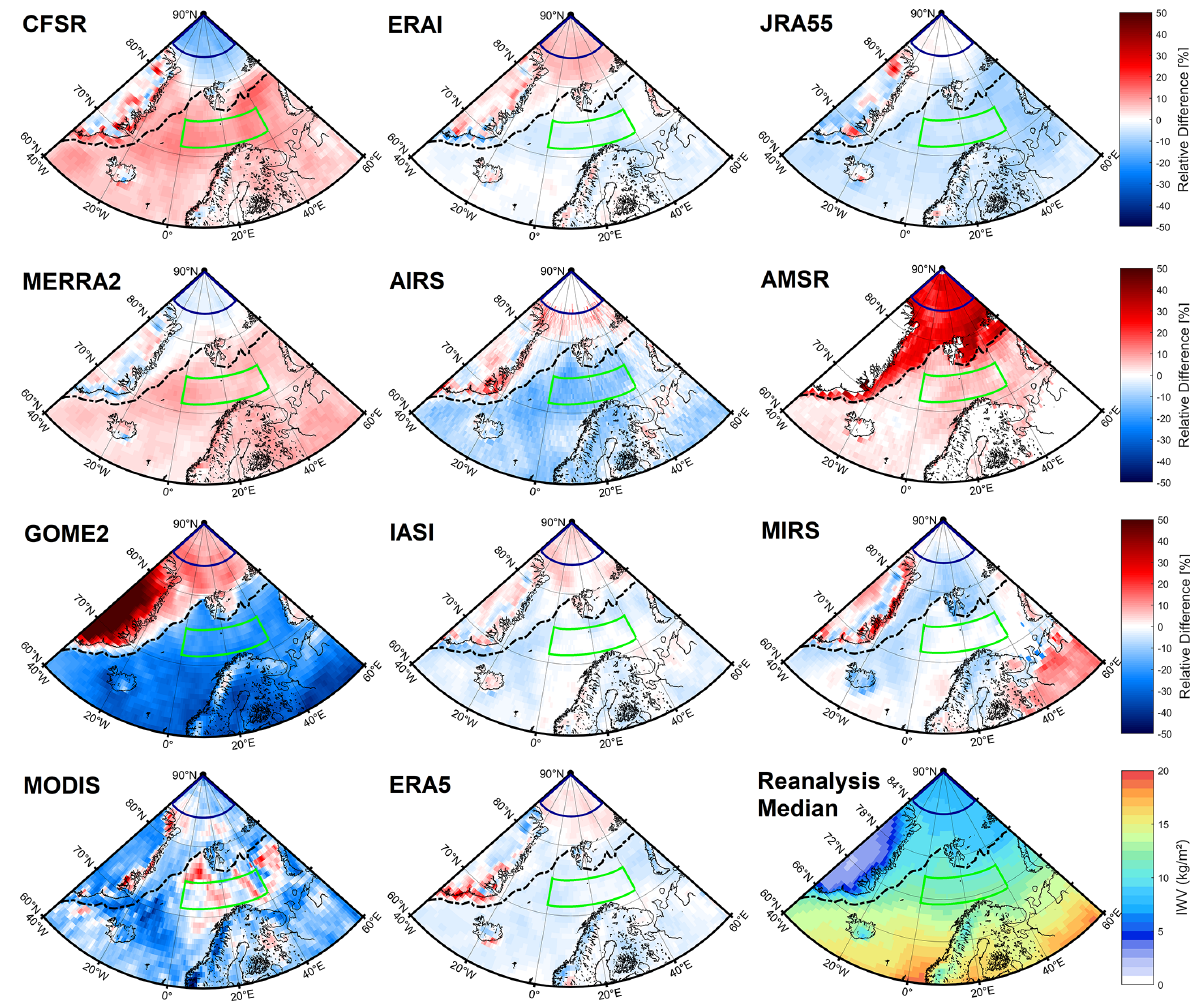
Figure 9. Relative difference between the reanalysis median (bottom right; CFSR, ERA-Interim, JRA-55, MERRA2) and the individual products over the study area for June 2017. The monthly mean sea ice edge for 15% sea ice concentration derived by the AMSR is shown as a black dash-dotted line. The central Arctic (dark blue) and open-ocean (green) regions are